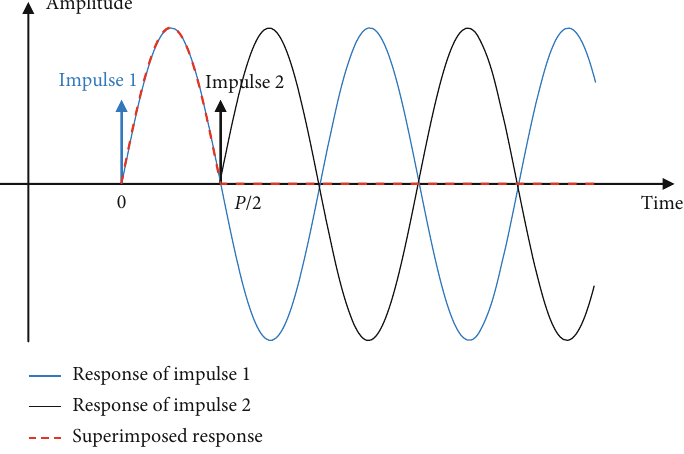
Figure 5: Basic principle of